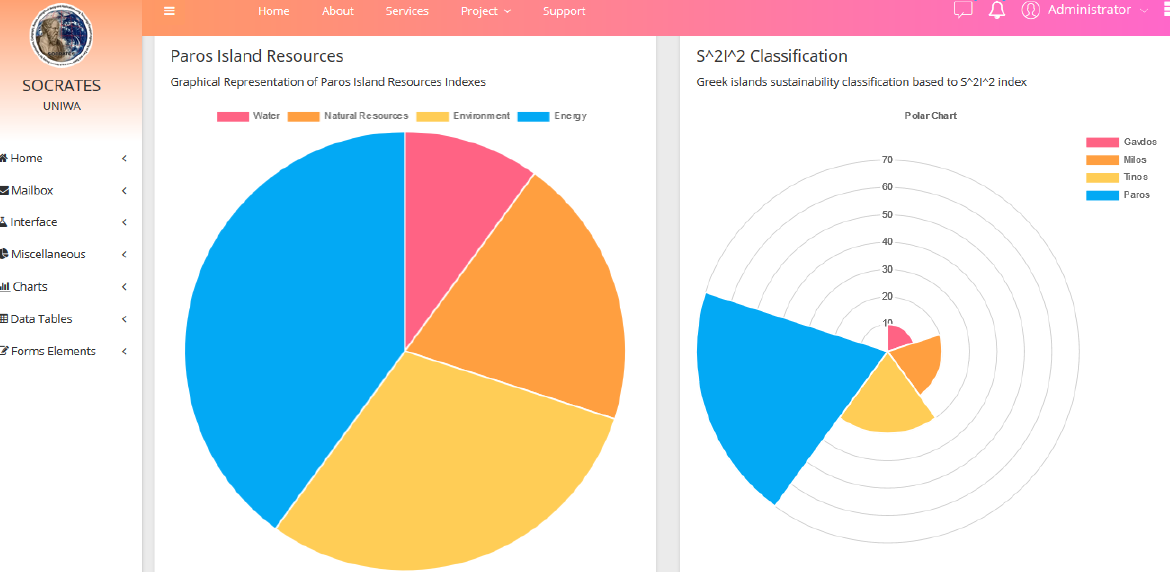
Figure 7. Two views of Paros island index, the sub-dimensions weighting (left) and the graphical comparison for sustainability to other 3 islands (right).